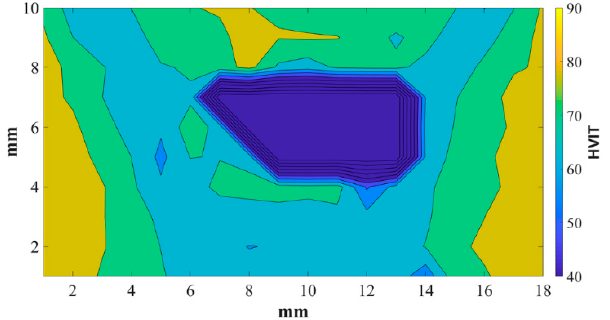
Figure 5. A HV05 microhardness map of the cross-section of the FSC sample. In the figure, the retreating side is on the left and advancing side is on the right.